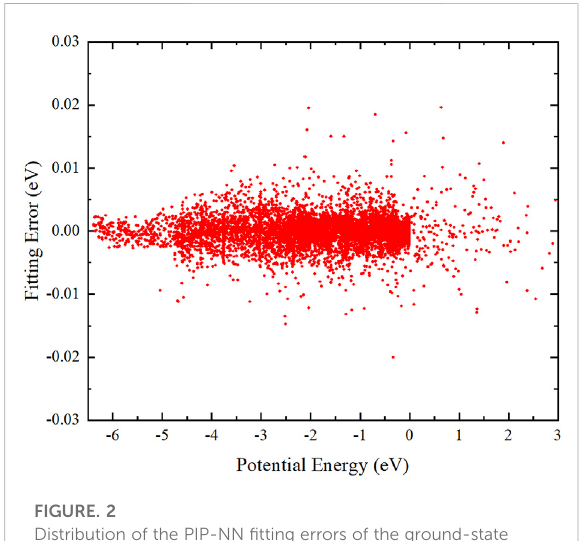
FIGURE 1 Comparison of the ab initio data and the NN fi tting results of the PECs of H 2 (X 1 Σ g + ) and BeH(X 1 Σ + ).